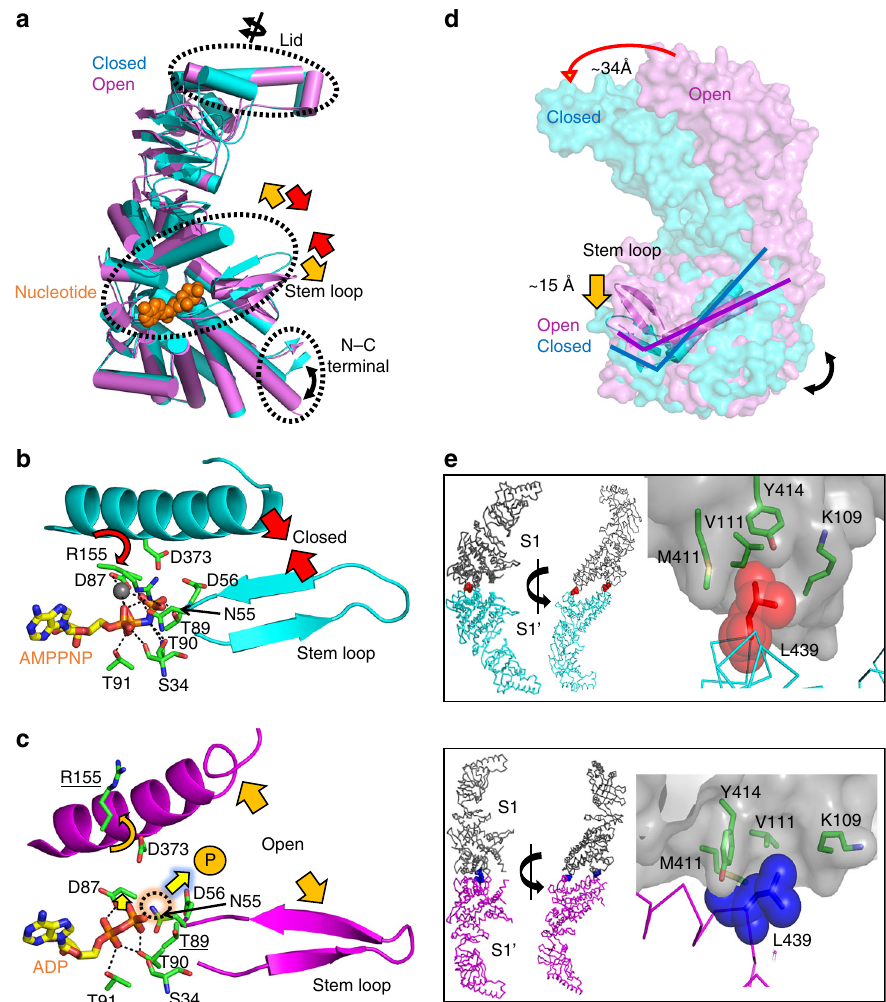
Fig. 4 Mechanism of ring closure in Ch-CPN. a Superposition of the open and closed subunits. Major conformational changes are indicated by black dotted circles. b , c Movements of the stem loop and the nucleotide-sensing loop by b AMPPNP (cyan) or c ADP binding (purple). Residues interacting with nucleotides and a magnesium ion are shown in green sticks and a gray sphere, respectively. A black dotted circle indicates the position of the hydrolyzed γ -phosphate represented by P. Movements of the stem loop and the nucleotide-sensing loop are represented by red (in b ) and orange (in c ) arrows. Residues that are involved in interactions with AMPPNP but do not interact with ADP are indicated in bold underline letters. d Subunit movements on ring closure. On ATP binding, the stem loop is shifted down about 15 Å and concurrently the apical domain moves inwards about 34 Å. e C- and O-interfaces of the closed (upper) and open Ch-CPNs (bottom). Two Leu439 residues in the interface between S1 and S1 ′ mediate inter ring communication (ball and stick) in the closed state (red) and the open state (blue), respectively. Residues forming the socket are presented as